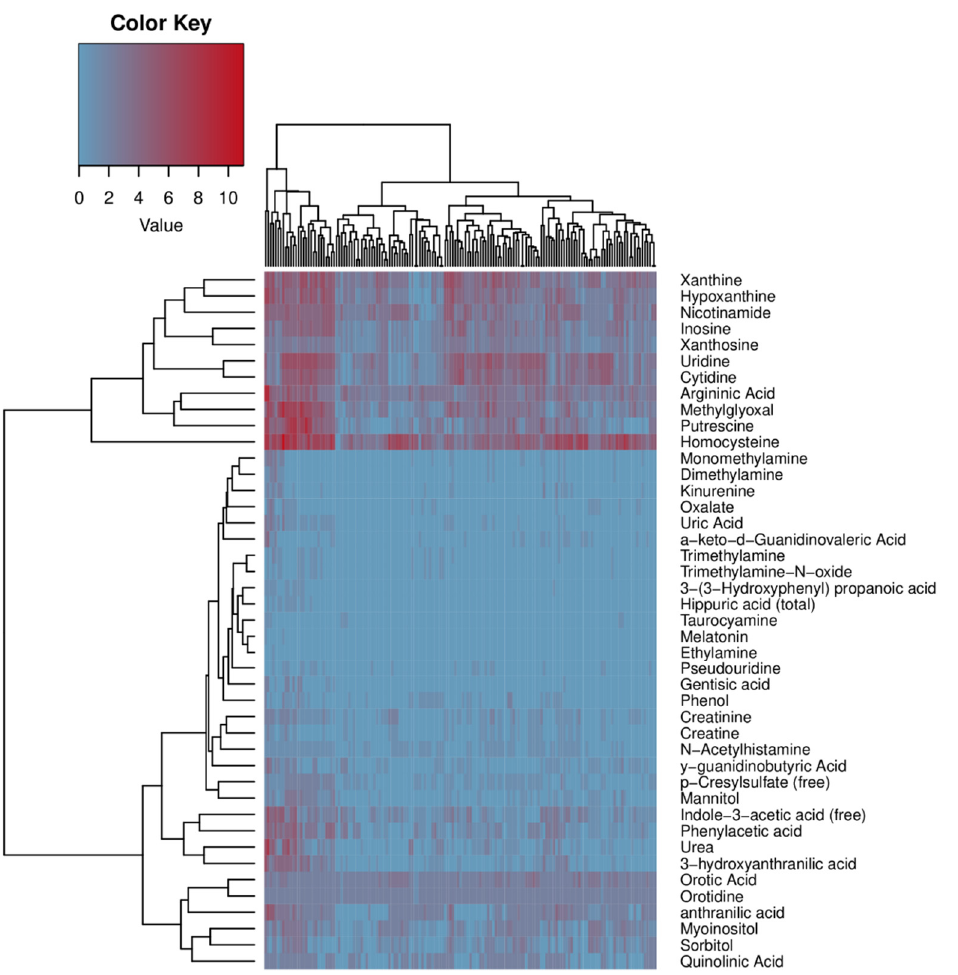
Figure 2. Cluster heatmap representing a clustering of toxins according to bacteria that can potentially synthesize them. Color represents the number of enzymatic reactions in given bacteria that can potentially lead to the synthesis of a toxin (see Supplementary Figure S1 for a high-resolution version with all bacteria names expanded).